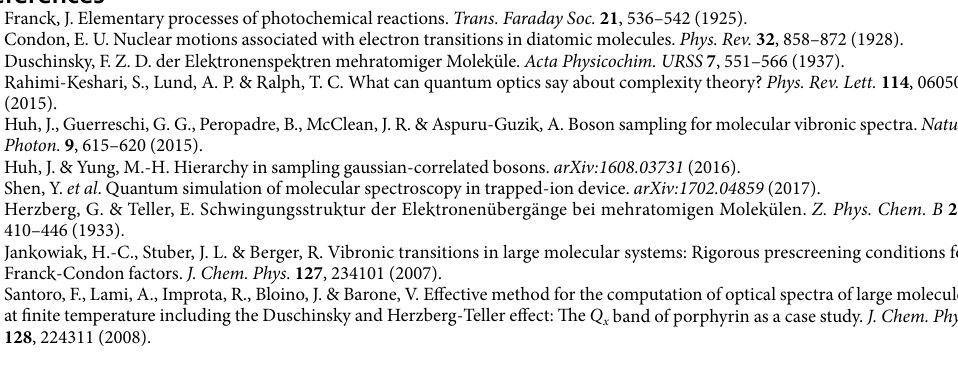
7 ScIenTIfIc REPORts | 7: 17561 | DOI:10.1038/s41598-017-17506-8